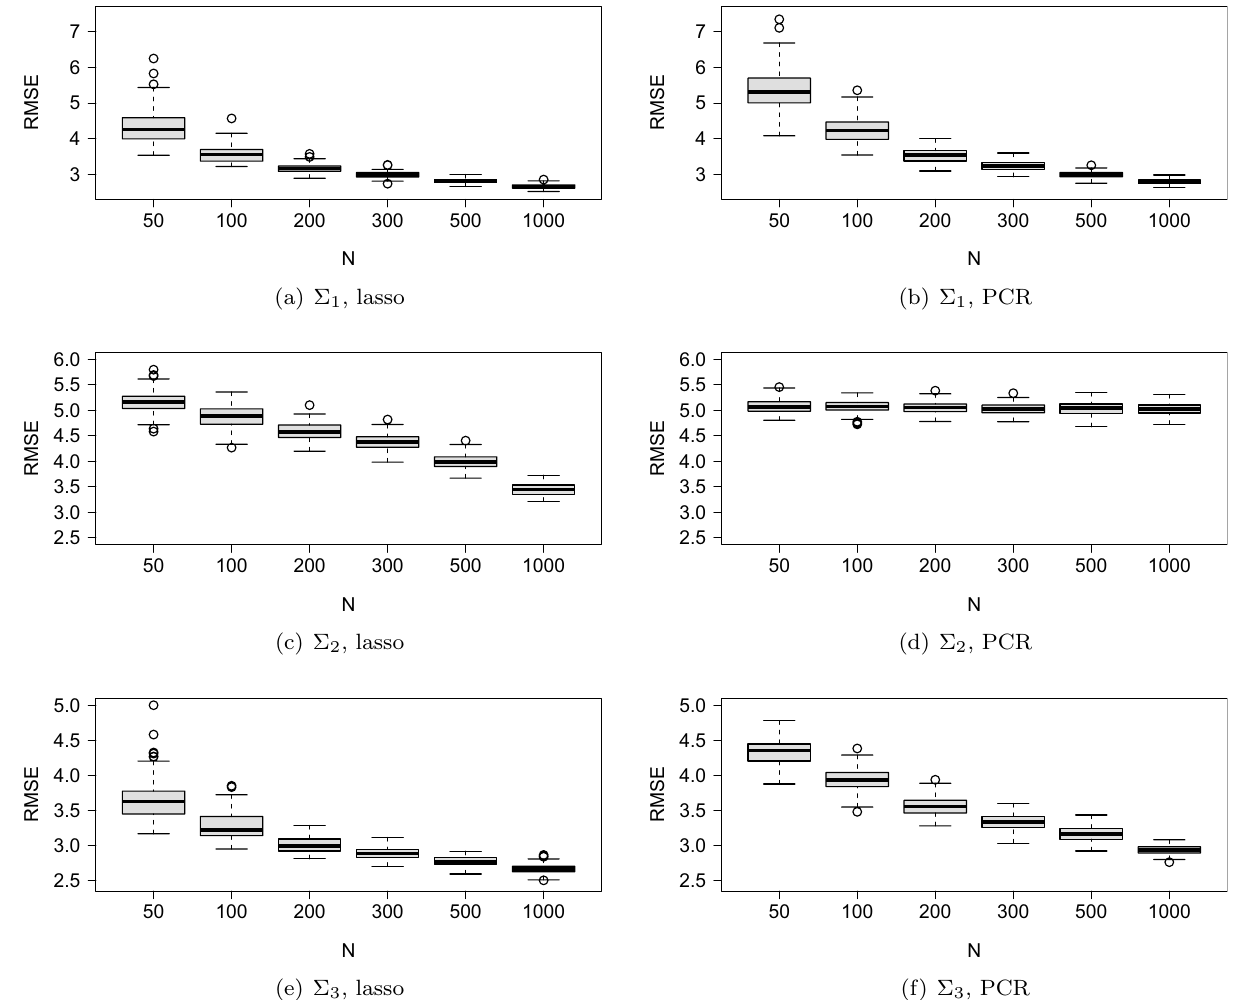
Figure 4. Box and whisker plot of RMSE. The variance-covariance matrix used in the simulations is (cid:31) 1 in ( a , b ), (cid:31) 2 in ( c , d ), and (cid:31) 3 in ( e , f ). The regression model is estimated by the lasso in ( a ), ( c ), and ( e ) and by PCR in ( b ), ( d ), and ( f